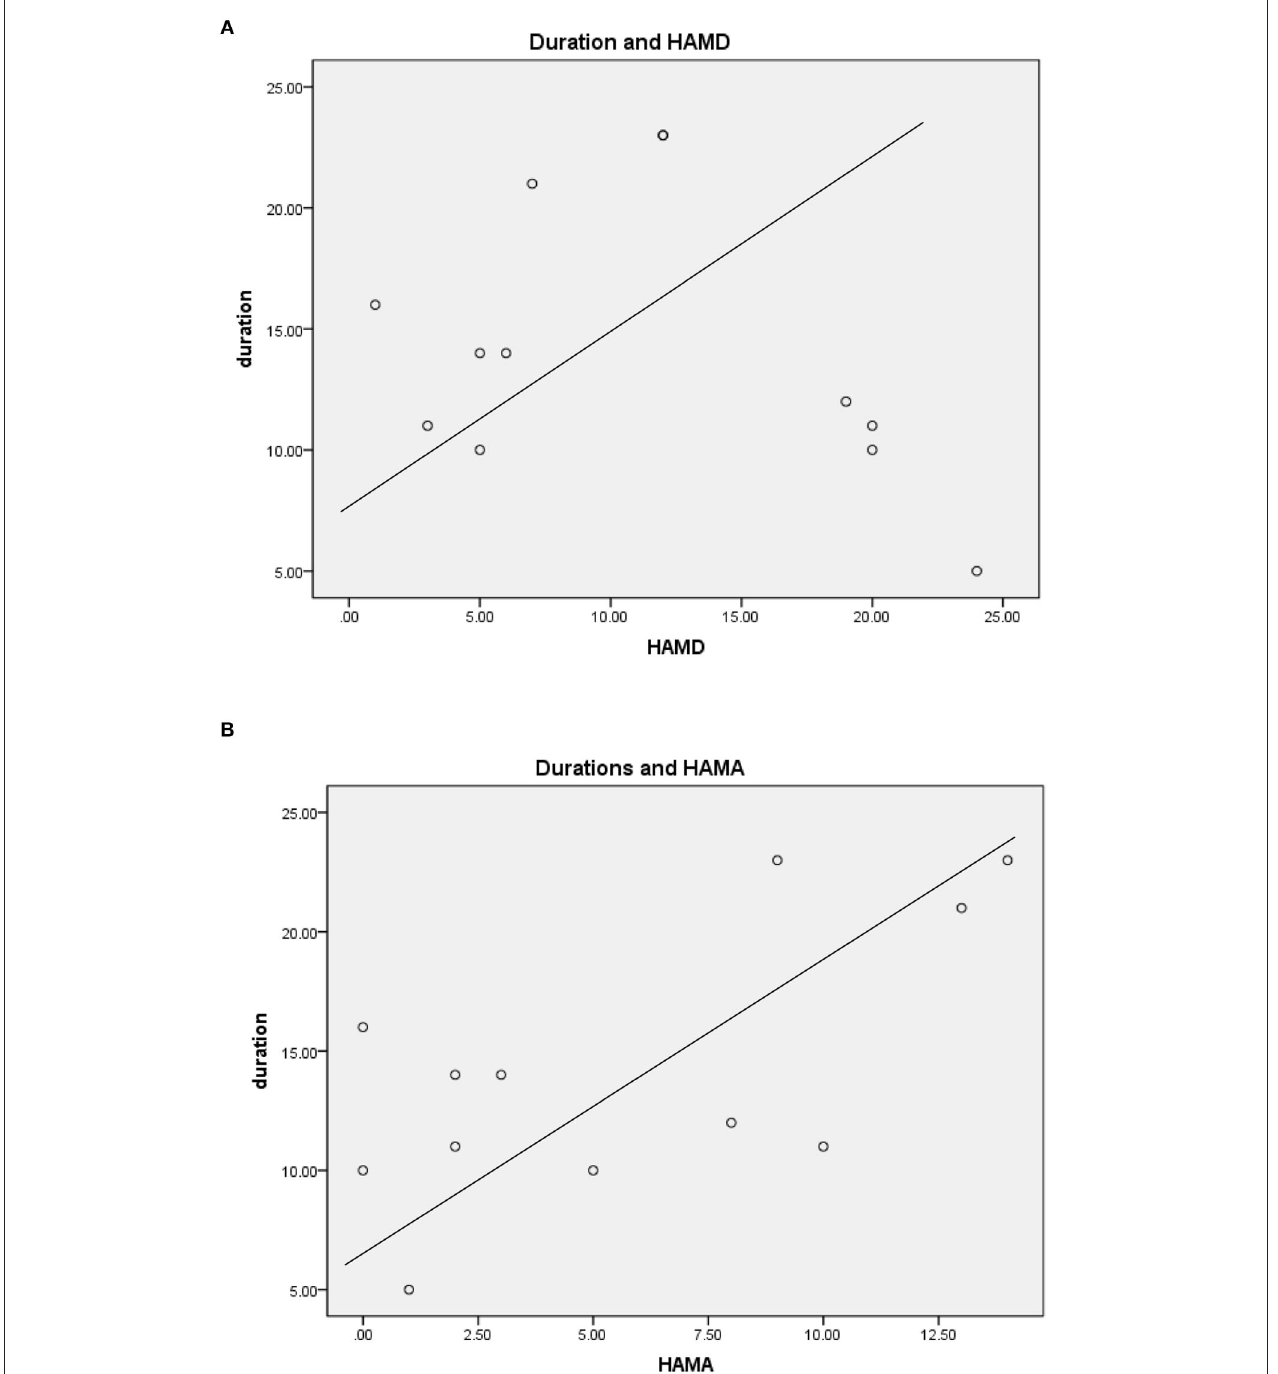
FIGURE 1 | (A) Durations of IP symptom and HAMD scores. (B) Durations of IP symptom and HAMA scores.